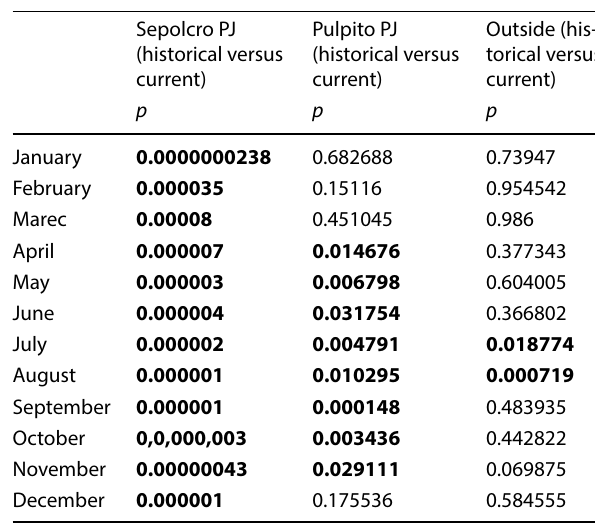
Table 1 T test calculated for mean monthly temperatures (historical 1934–1937 versus current 2017–2019) for Postojnska Jama (PJ) sites (Pulpito, Sepolcro) and